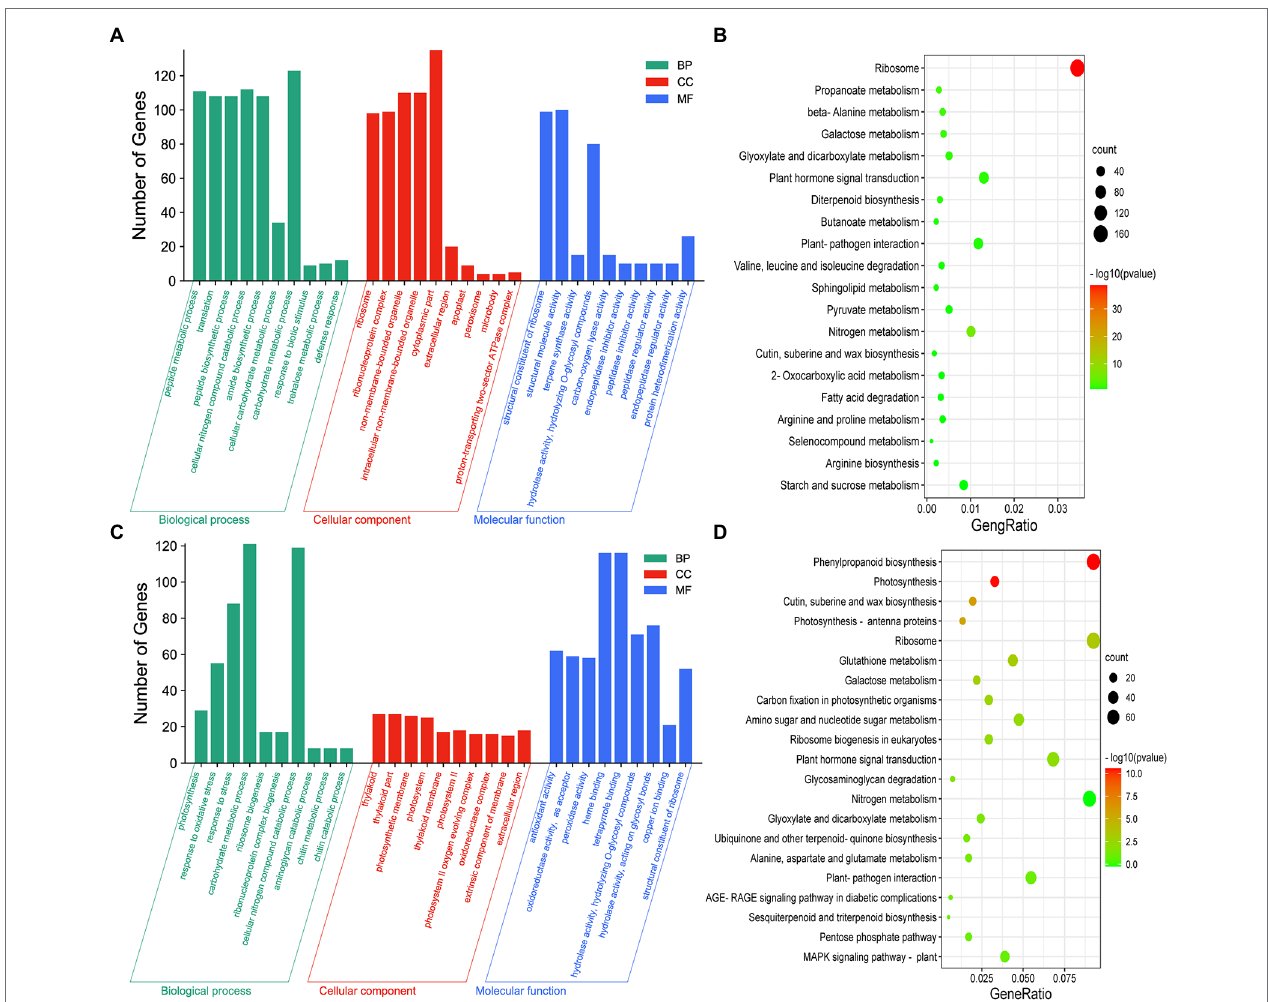
FIGURE 3 | Analysis of differential expression genes (DEGs) with different expression patterns in axillary bud under amino acids related treatments. The GO enrichment (A) and KEGG pathway enrichment (B) analysis of DEGs at 0 μ m melatonin compared to 1.5 mm Lys + 0.5 mm Arg. The GO enrichment (C) and KEGG pathway enrichment (D) analysis of DEGs at 1.5 mm Lys + 0.5 mm Arg compared to 1.5 mm Lys + 0.5 mm Arg + 1 μ m melatonin. Y-axis indicates the number of GO annotated genes, and X-axis indicates the processes/components in different biological processes, cellular components, and molecular functions (A,C) . Y-axis indicates KEGG pathway, and X-axis indicates the ratio of the number of enriched genes to the number of annotated genes in the pathway (B,D) . The color of the dot represents value of p , and the size of the dot represents the number of DEGs mapped to the referent